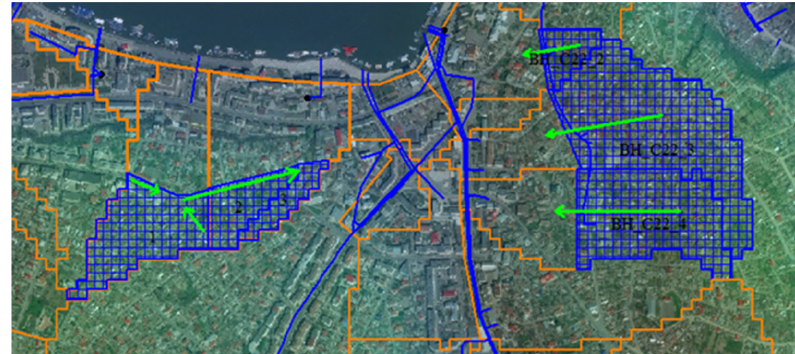
Figure 17. Additional surfaces that discharge in the area of objects 2, 3, 4, 5, and 6.